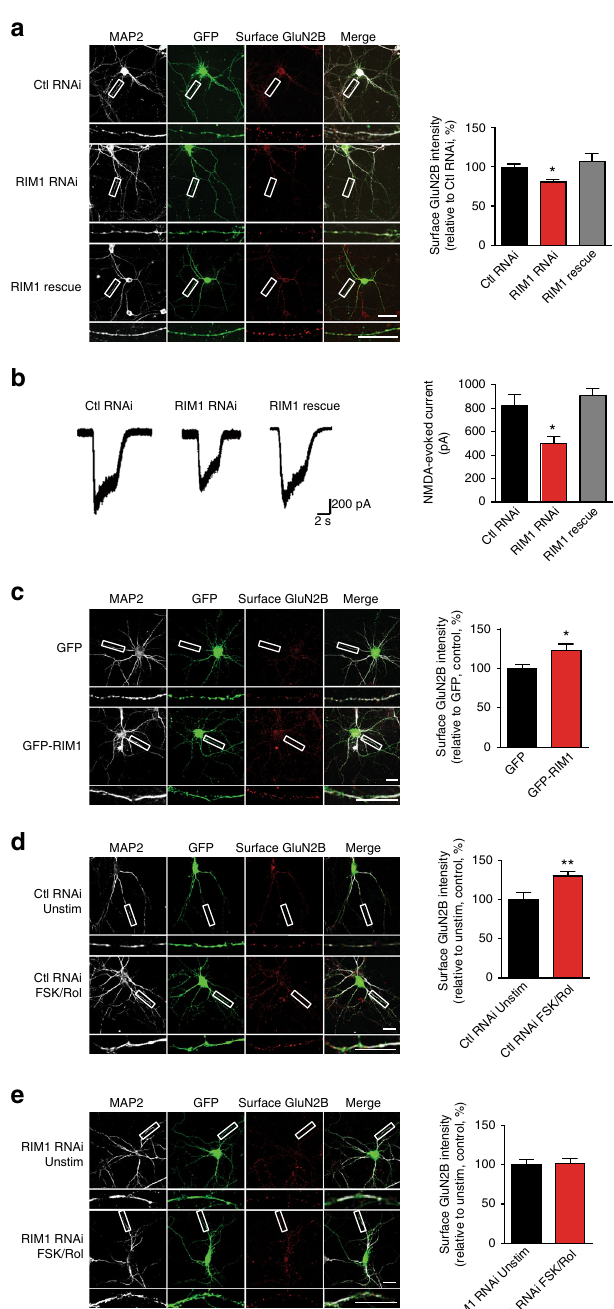
traf fi cking. a RIM1 KD signi fi cantly decreases the surface level of GluN2B/ NMDARs. Left: cultured hippocampal neurons were transfected with GFP- tagged control RNAi plasmid (control RNAi, n = 45 neurons from three independent cultures), GFP-tagged RIM1 shRNA plasmid (RIM1 RNAi, n = 29 neurons from three independent cultures), or GFP-tagged RIM1 shRNA- resistant plasmid (RIM1 rescue, n = 26 neurons from three independent cultures), and surface GluN2B was detected by live cell-surface staining. Scale bar, 20 µ m. Right: statistical analysis of surface GluN2B intensity. One-way ANOVA with Dunnett ’ s post test, * p < 0.05. b RIM1 KD signi fi cantly reduces the evoked NMDAR currents in cultured cortical neurons. Left: representative recordings of NMDAR currents evoked by NMDA together with glycine. Left: representative traces of NMDA-evoked currents from neurons transfected with control RNAi ( n = 11 neurons from three independent cultures), RIM1 RNAi ( n = 11 neurons from three independent cultures), or RIM1 KD rescue ( n = 26 neurons from three independent cultures) plasmids. Right: statistical analysis of NMDAR- evoked currents. One-way ANOVA with Dunnett ’ s post test, * p < 0.05. c RIM1 overexpression signi fi cantly increases the surface GluN2B/NMDARs levels. Left: representative images of surface GluN2B staining in cultured hippocampal neurons transfected with GFP-RIM1 ( n = 20 neurons from three independent cultures) or pEGFP-N1 ( n = 35 neurons from three independent cultures). Scale bar, 20 µ m. Right: statistical analysis of surface GluN2B intensity; t -test, * p < 0.05. d Treatment with Forskolin (20 μ M) and Rolipram (0.1 μ M) for 30 min (FSK/Rol, n = 51 neurons from three independent cultures) signi fi cantly increases the surface localization of endogenous GluN2B in cultured hippocampal neurons transfected with control RNAi plasmid compared with DMSO ( n = 27 neurons from three independent cultures). Scale bar, 20 µ m; t -test, ** p < 0.01. e Treatment with FSK/Rol ( n = 25 neurons from three independent cultures) does not alter the surface localization of endogenous GluN2B in neurons transfected with RIM1 RNAi plasmid compared with DMSO ( n = 15 neurons from three independent cultures). Scale bar, 20 µ m; t -test, p >